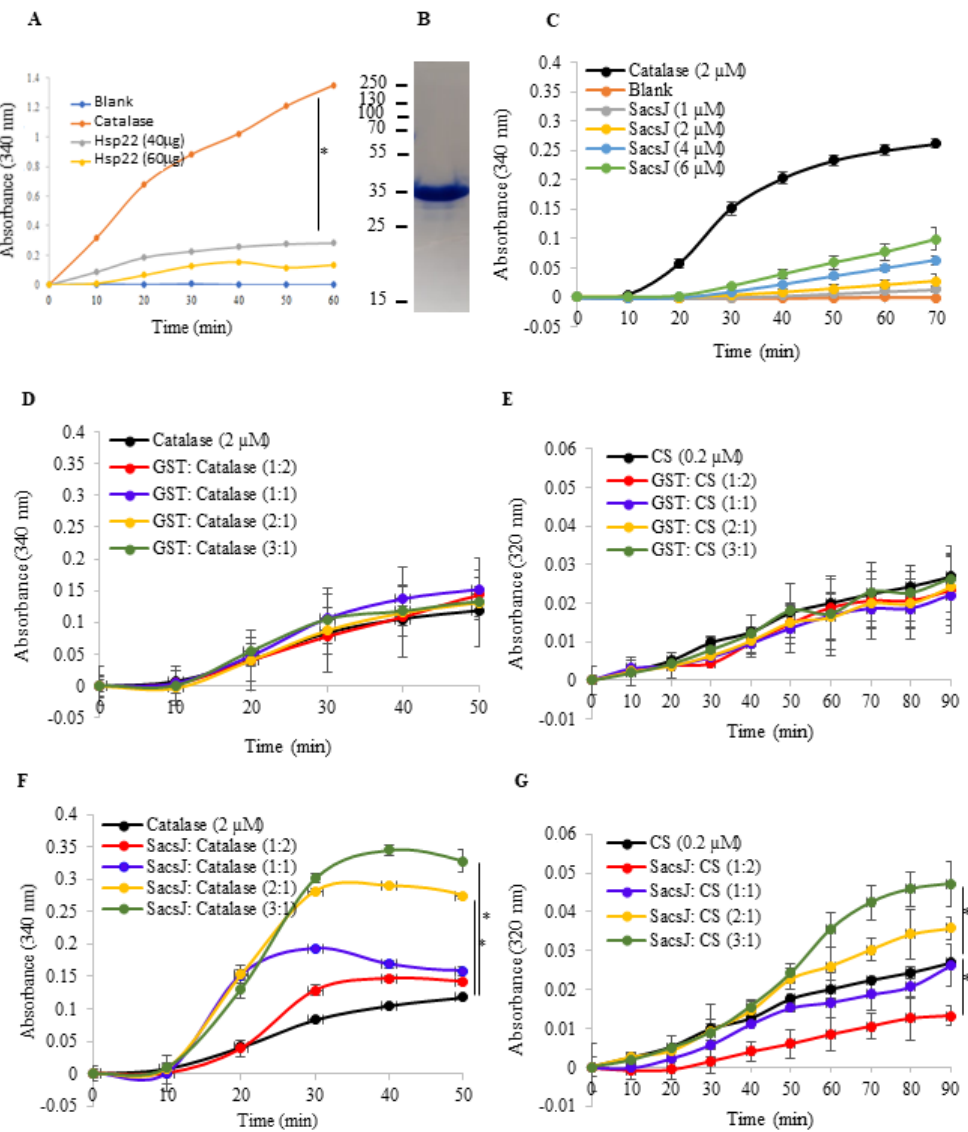
Figure 4. SacsJ domain did not act as a chaperone to reduce heat-denaturation of catalase or citrate synthase in an in vitro assay. ( A ) Absorbance at 340 nm of catalase (2 µM) incubated with or without Hsp22 used as a positive control (40 or 60 µg) heated at 60 °C. ( B ) Coomassie brilliant blue staining of a SDS-PAGE of purified recombinant SacsJ protein used in these assays. ( C ) Absorbance at 340 nm, as a function of time in an assay for heat-denaturation of catalase (2 µM) at 60 °C compared to heat-induced denaturation in the presence of increasing concentrations of SacsJ-GST (1 – 6 µM). ( D , E ) Absorbance at 340 nm of catalase (2 µM) or at 320 nm citrate synthase (CS) (0.2 µM) incubated with or without GST (1 – 6 µM) heated at 60 °C for catalase or 45 °C for CS. ( F , G ) Absorbance at 340 nm and 320 nm of catalase (2 µM) or citrate synthase (CS) (0.2 µM) incubated with or without SacsJ- GST (1 – 6 µM) heated at 60 °C for catalase or 45 °C for CS. * p < 0.05 vs. catalase or CS alone, one- way n = 3)